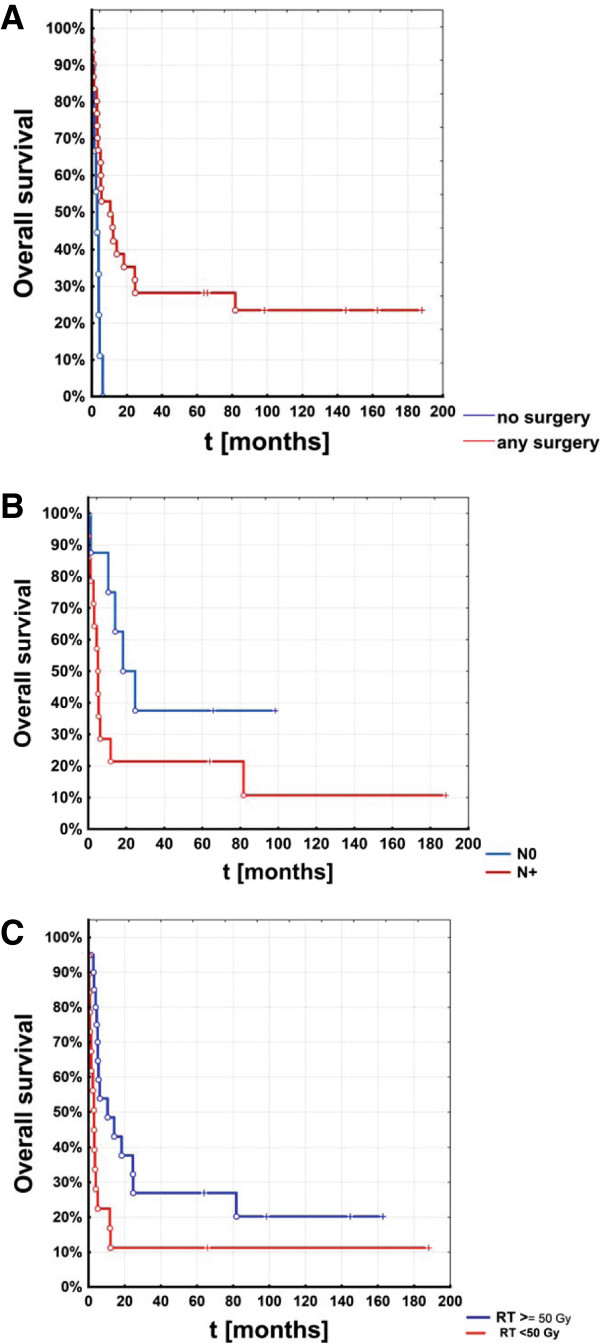
Overall survival in subgroups of patients with anaplastic thyroid cancer: significantly improved survival was seen in (A) patients with any surgery vs. no surgery (p = 0.02) (B) patients with N0 status vs. N + status (p = 0.041) and (C) patients with a radiotherapy dose of at least 50 Gy vs. lower doses (p = 0.022).